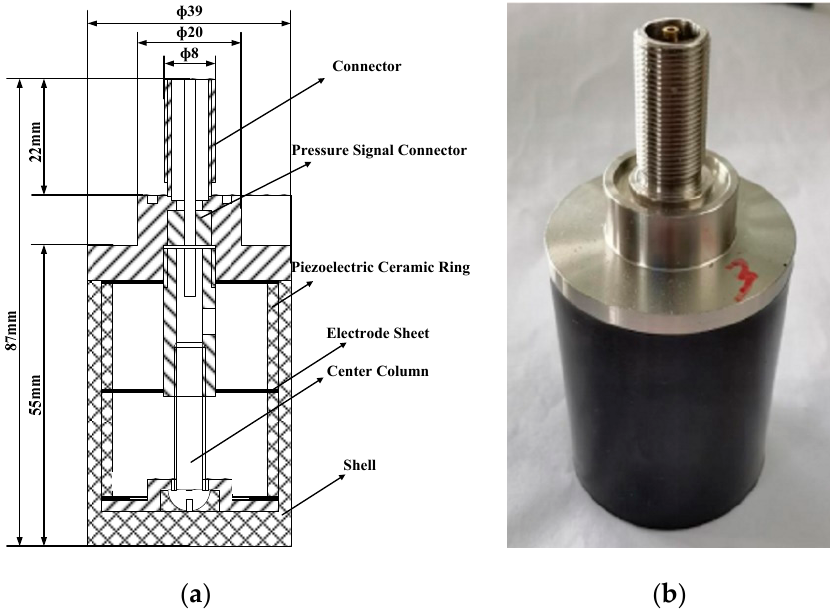
Figure 6. ( a ) Plane structure of piezoelectric ceramic microphone; ( b ) Physical picture of piezoelectric ceramic microphone.